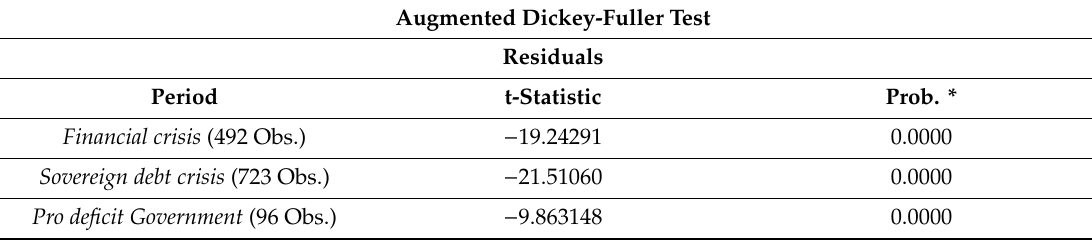
Table A1. Augmented Dickey–Fuller test.